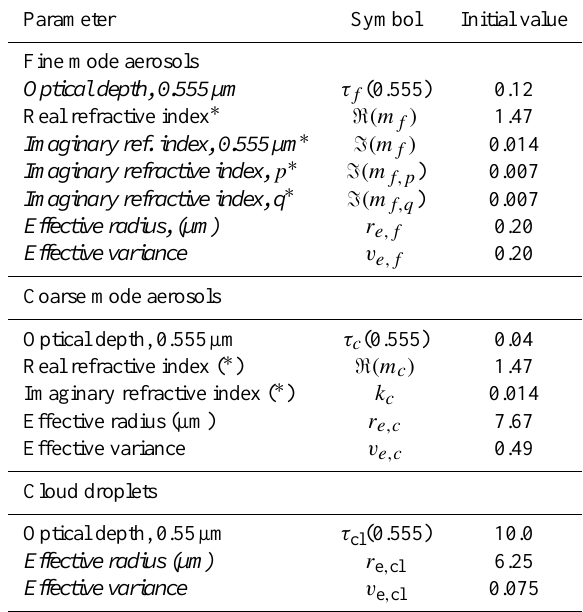
Table 1. Retrieved aerosol parameters and the initial values used in optimization. Parameters listed in italics are optimized during the retrieval, while all others are kept constant. ∗ : Refractive Index val- ues have no spectral dependence in the initial values, although the spectral dependence of the fine mode aerosol imaginary component is allowed to vary as described in Sect. 2.4.